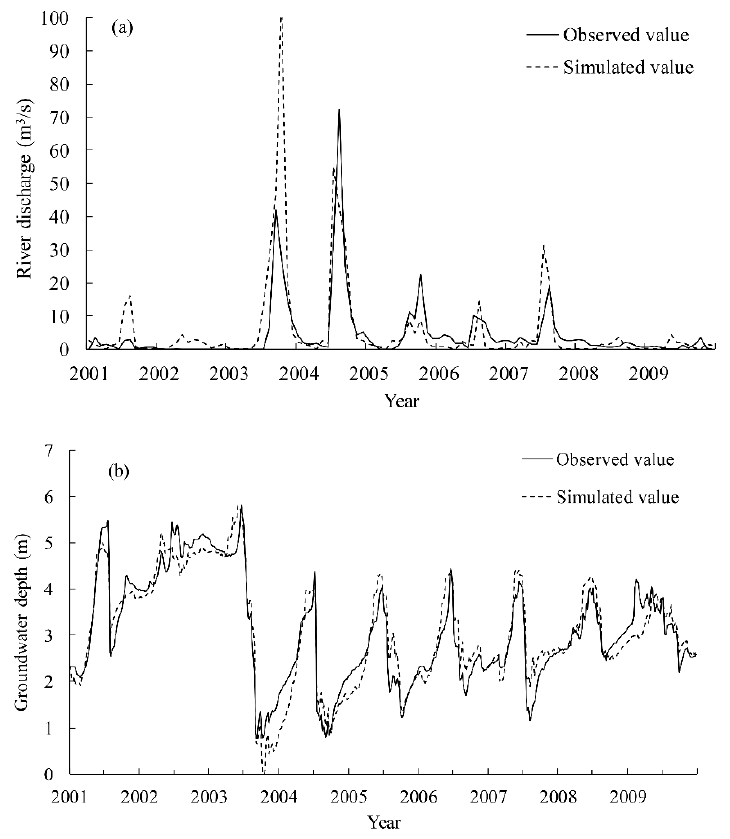
Figure 3. Comparison of the observed and simulated processes of ( a ) the river discharge and ( b ) the groundwater depth under maximizing the single-objective function NSE flow.